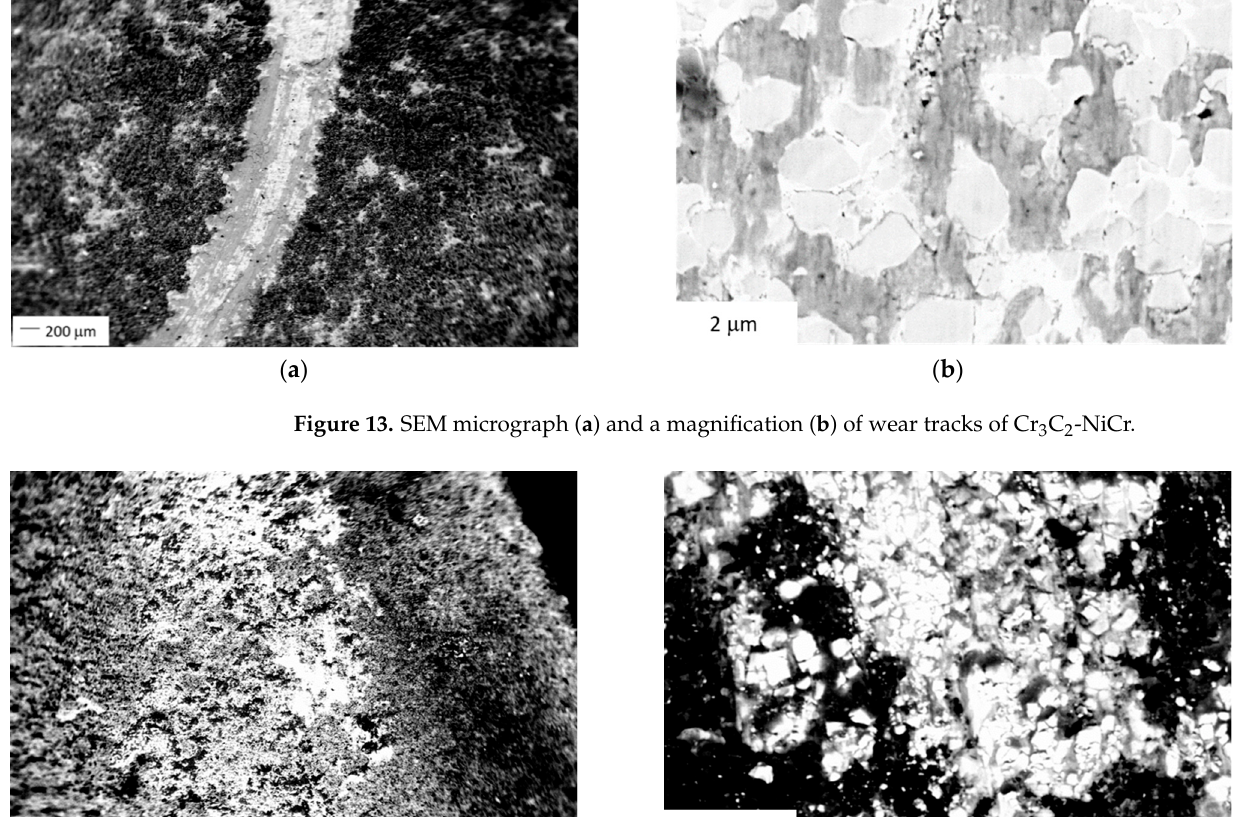
Figure 12. SEM micrograph ( a ) and a magnification ( b ) of wear tracks of WC-Co-Cr.